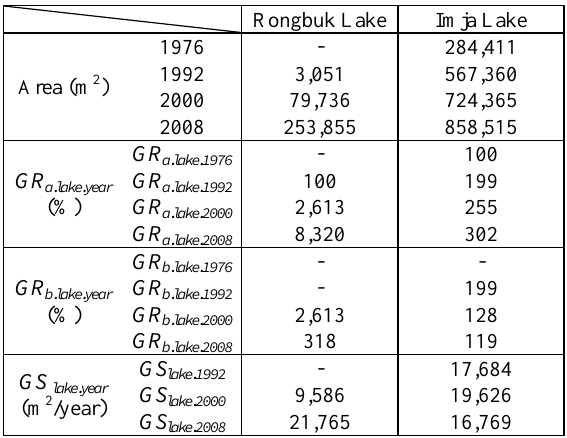
Figure 4. Map of time-series changes of Rongbuk Lake and Imja Lake (Basemap source: